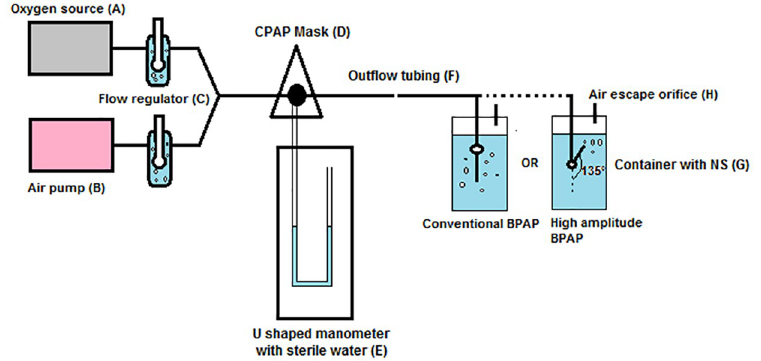
Fig 2. A simplified model of modified improvised BCPAP for adults. BCPAP, bubble continuous positive airway pressure; CPAP, continuous positive airway pressure; NS, Normal Saline.